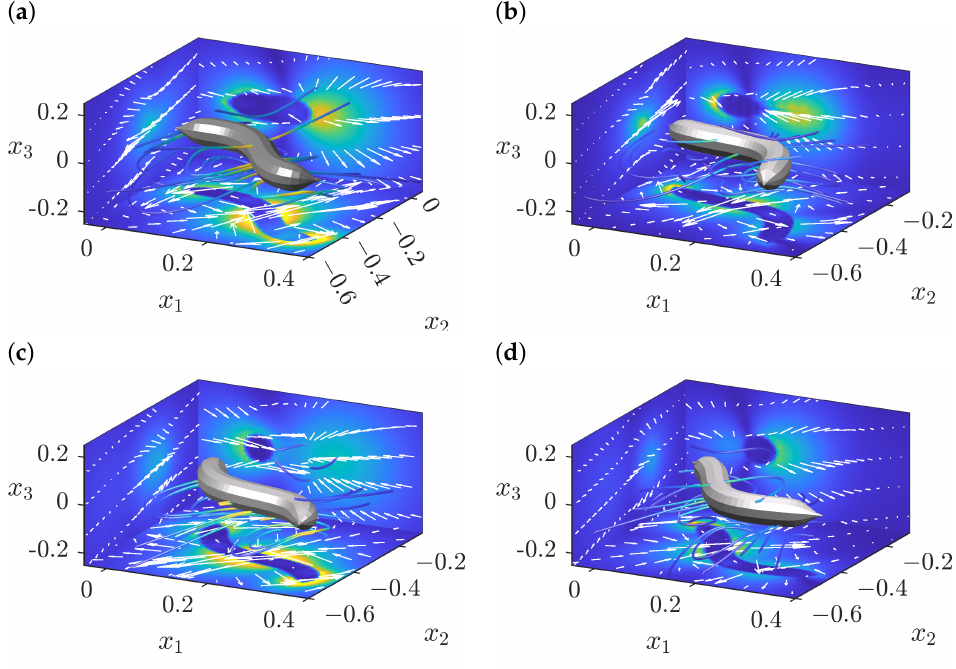
Figure 9. Undulatingnonslender swimmer, full boundary integral calculation, with maximum radius a 0 = 0.06. ( a – d ) veloc- ity field in the fluid with instantaneous streamlines at four approximately equally spaced intervals during the beat